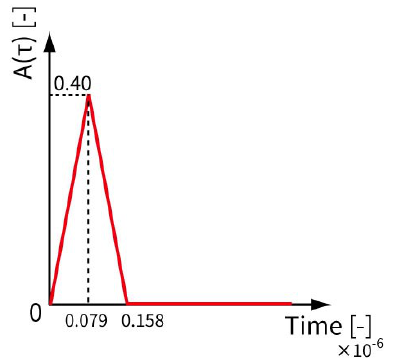
Figure 5. Acceleration as a function of dimensionless time for the model of lateral impact